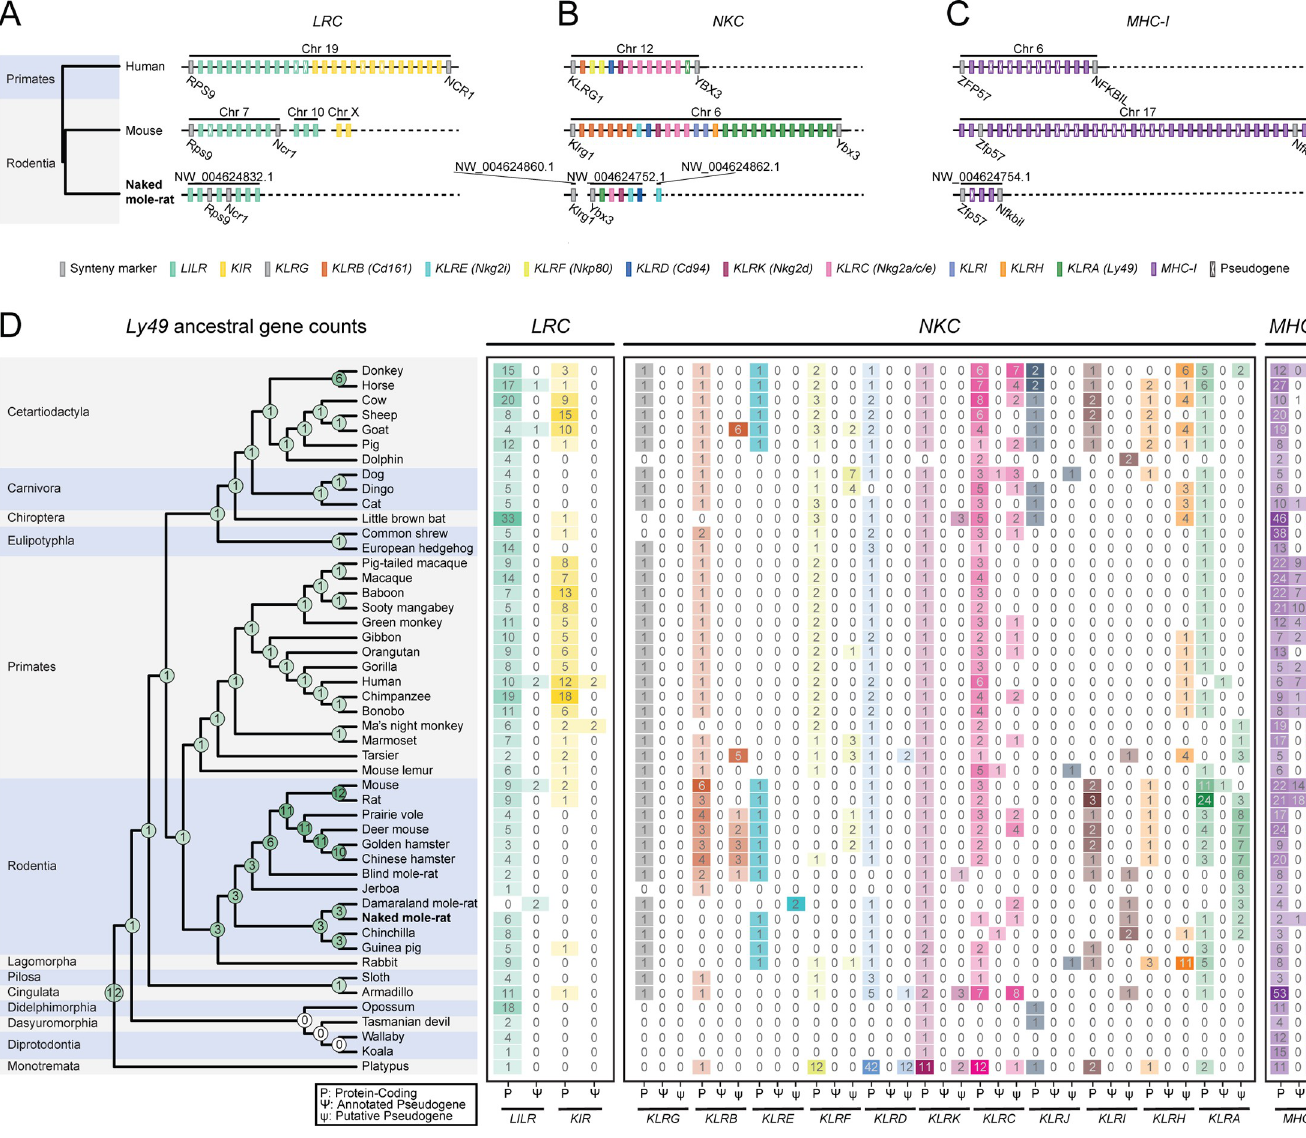
PLOS Biology | https://doi.org/10.1371/journal.pbio.3000528 November 21,